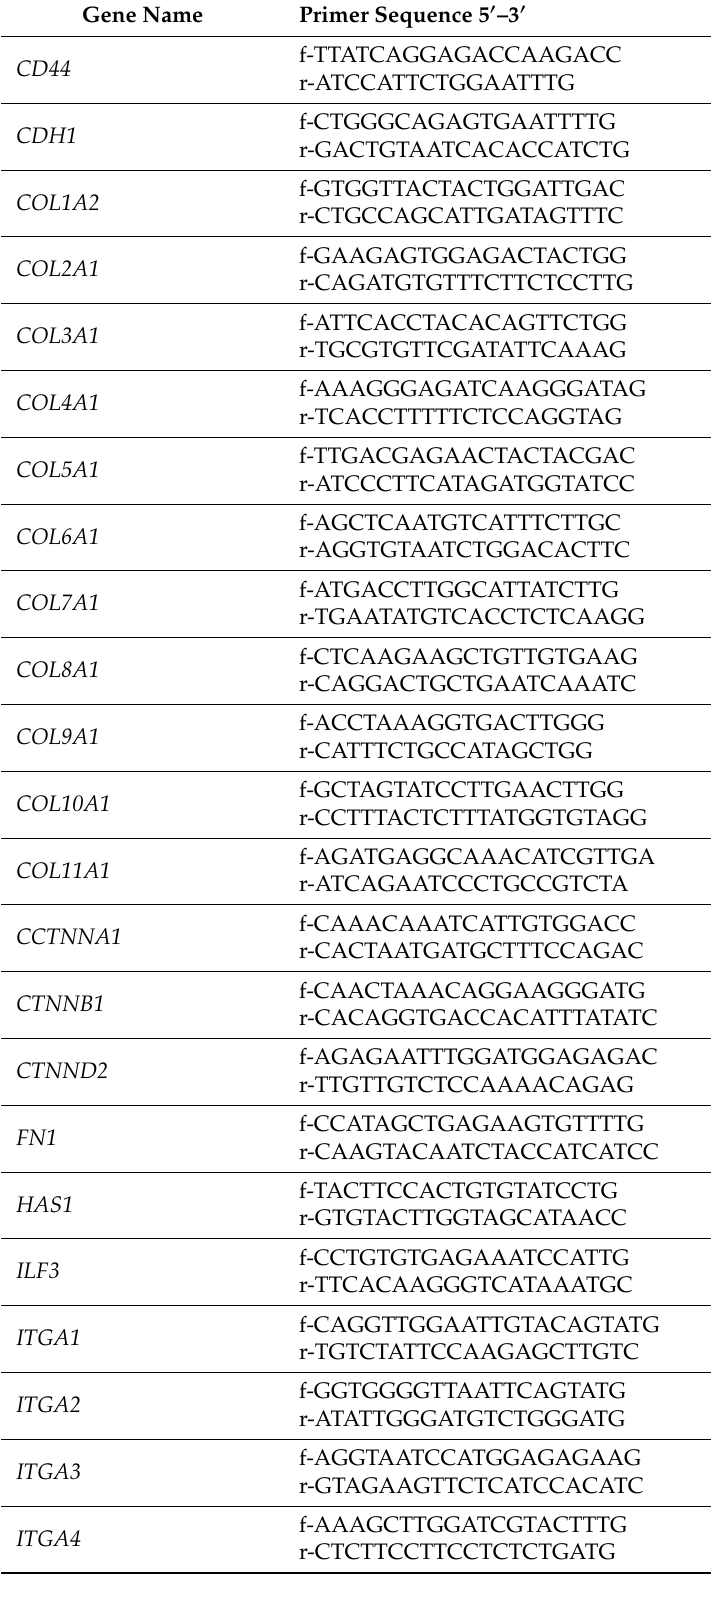
Table 3. Primer sequences of genes belonging to the “Extracellular Matrix and Adhesion Molecules” pathway analyzed using real-time